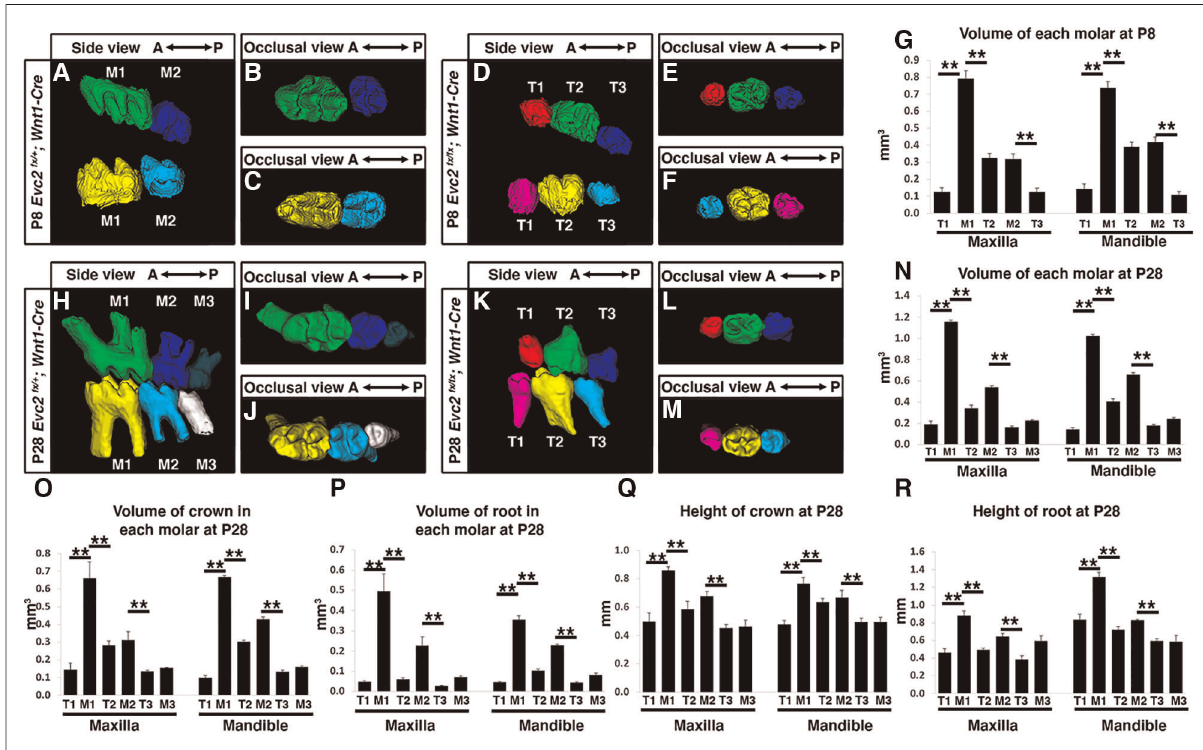
FIGURE 3 Mandible molars at P8 from controls ( A – C ) and Evc2 Wnt1- mutants ( D – F ) were reconstructed from micro-CT scans. The volume of each molar at P8 were quanti fi ed and shown in ( G ). Mandible molars at P28 from controls ( H – J ) and Evc2 Wnt1 mutants ( K – M ) were reconstructed from micro-CT scans. The volume of each molar at P28 ( N ), the volume of crown ( O ), the volume of root ( P ), the height of crown ( Q ), and the height of root ( R ) were quanti fi ed and shown. For molar volumes at P8, n =4, for maxilla, M1 vs T1, p <0.01; M1 vs T2, p <0.01; M2 vs T3, p <0.01; for mandible, M1 vs T1, p